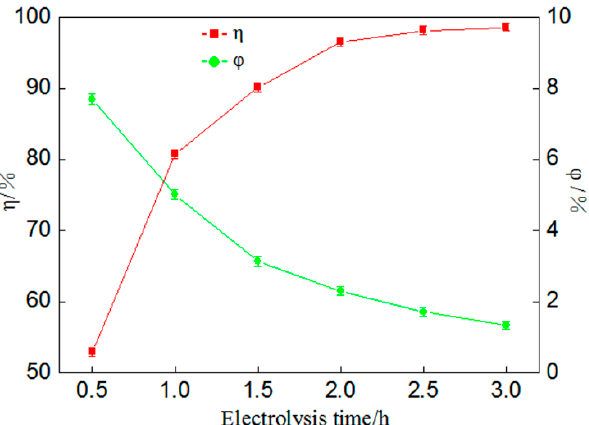
Figure 5. Influence of electrolysis time on percentage of gold deposition ( η ) and coulombic efficiency ( ϕ ).